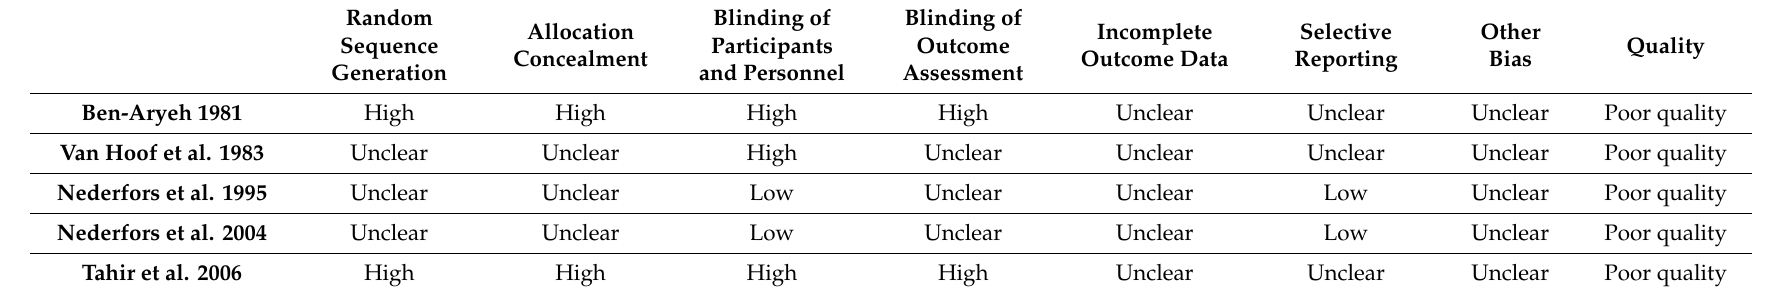
Table 2. The Cochrane risk of bias of the included clinical trials.